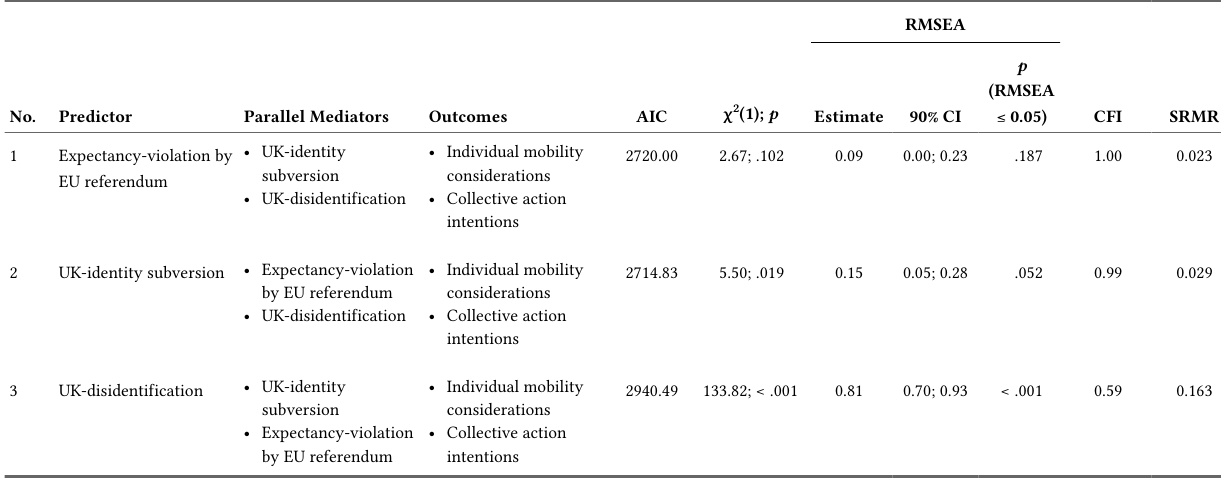
Fit Indices for Hypothesized Model and Alternative Models (Without Requesting Covariances Between Mediators)